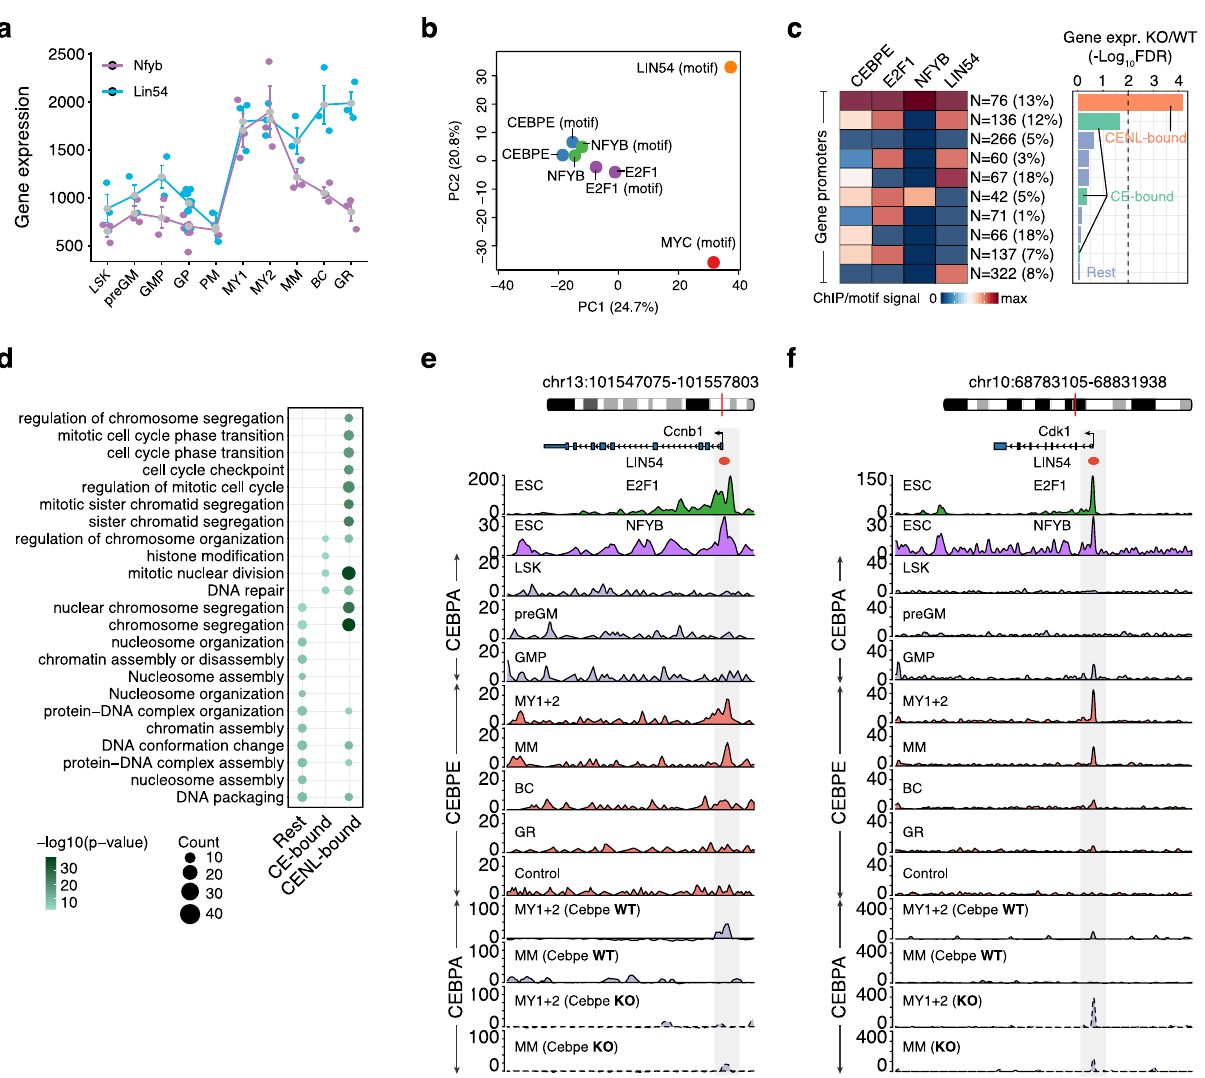
Fig. 5 CEBPE inhibits G2/M progression by repression of E2F target gene expression. a Expression pro fi les of Nfyb and Lin54 during granulocytic differentiation (mean; whiskers represent the standard error) ( N = 3 (LSK), 3 (preGM), 3 (GMP), 6 (GP), 2 (PM), 3 (MY1), 3 (MY2), 3 (MM), 3 (BC), and 3 (GR), biological replicates). b PCA plot showing similar binding pro fi les for CEBPE, NFYB, and E2F1, but not for MYC and LIN54, at promoters of G2/M genes, as inferred by the ChIP-seq binding signal and binding motif scores. c Cluster B(MY) genes, including G2/M phase genes, were divided into gene subclasses based on the combinatorial binding of four TFs (CEBPE = C, E2F1 = E, NFYB = N, LIN54 = L) ( N > 30). CENL subclass (orange): Binding of all four TF. CE subclass (green): Binding of C and E with or without additional binding of either N or L. Rest (blue): Binding of other TF combinations of C, E, N, L, or none of these. C ebpe KO mice demonstrated marked upregulation of genes whose promoters were bound by all the four TFs (i.e., CENL-bound genes). In contrast, CE-bound and the “ Rest ” group of genes exhibited minimal upregulation in Cebpe KO vs. Cebpe WT mice. The percentages of genes from each TF binding subclass are depicted in brackets. d Functional gene categories enriched among genes from TF binding subclasses. e , f Genome browser view of two key G2/M phase regulators, Ccnbb 4 ( e ) and Cdk1 ( f ) bound by all four TFs at their promoters (CENL subclass) in WT and Cebpe KO mice (only CEBPA). Source data are provided as a Source Data fi